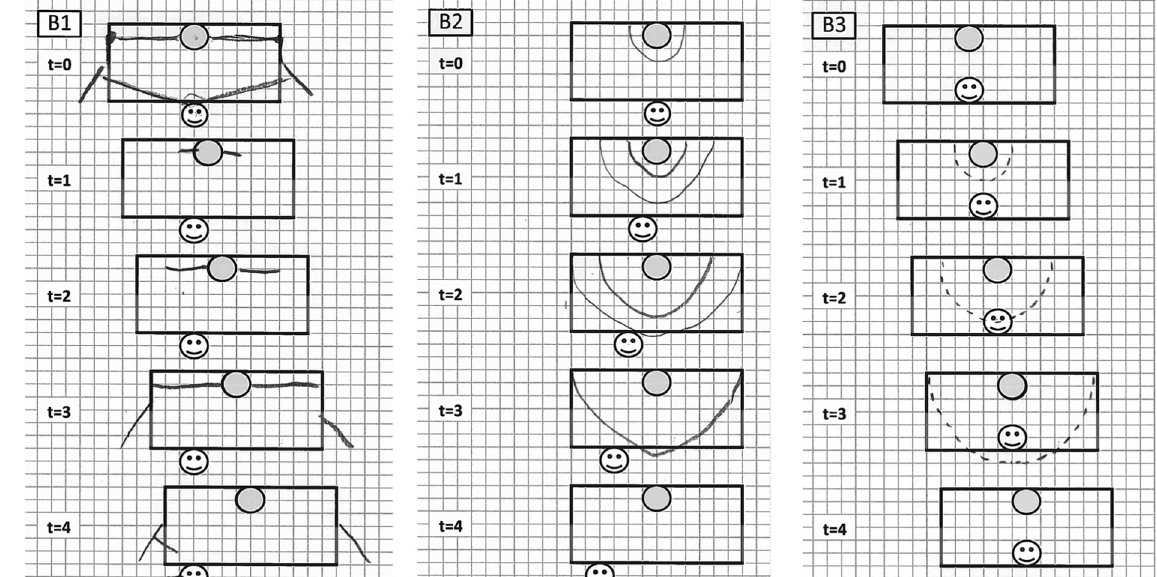
FIG. 5. EDs of participants who drew uniform light propagation relative to the lamp. The position of the light flash changes with two squares relative to the position of the lamp. The ED on the left shows the drawing of a participant who indicated the distance the light has covered as a path length. The other participants drew wave